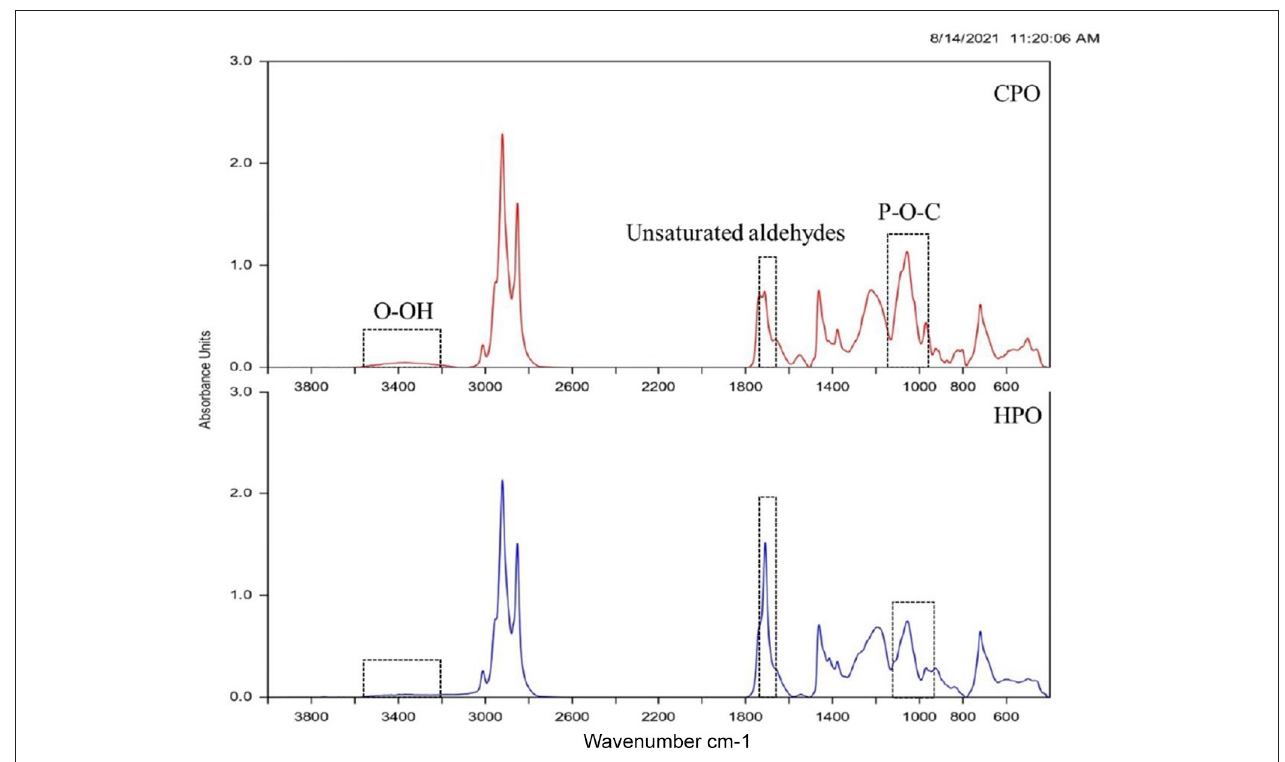
FIGURE 4 | FTIR spectra of CPO and HPO. CPO: Oil extracted from cephalothorax; HPO: oil extracted from